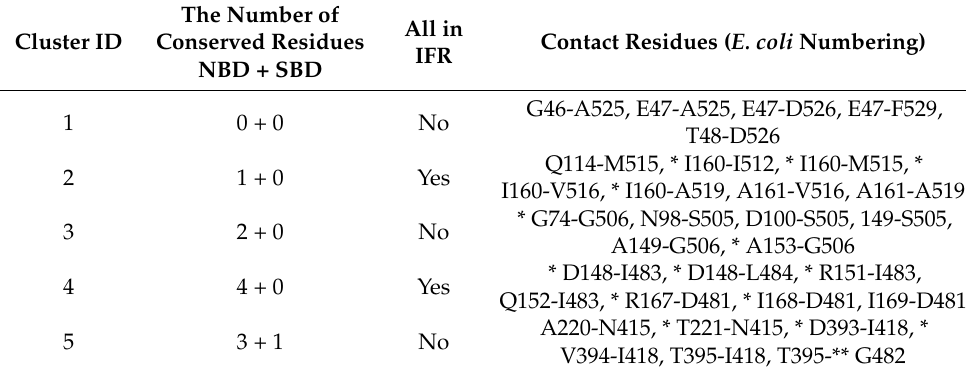
Table 1. E. coli Hsp70 contacts within each of identified clusters. * conserved residue NBD, ** conserved residue